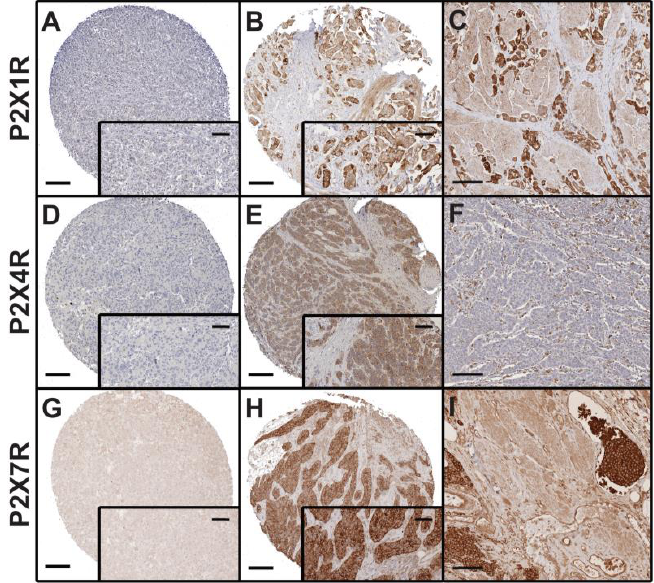
Figure 2. P2X1, P2X4, and P2X7 receptor expression in muscle-invasive bladder cancer (MIBC). ( A – C ) Representative photomicrographs show TMA samples with low ( A ) and high ( B ) P2X1R expression in cancer cells of MIBC. Compared to smooth muscle cells, muscle infiltrating cancer cells in ( C ) show strong distinct membranous staining. ( D – F ) TMA samples of MIBC with low ( D ) and high ( E ) P2X4R expression are shown. MIBC cells exhibit membranous and partially fine-granular cytoplasmic P2X4R staining, while tumor-infiltrating immune cells show strong im- ( G – I ) Low and high P2X7R expression patterns in MIBC are shown in ( G ) and ( H ), respectively. Cancer cells between muscle cells and in lymphatic vessels are highlighted by strong membranous P2X7R expression ( I ). Scale bars equal 100 µ m (outer pictures and ( C , F , I )) and 20 µ m